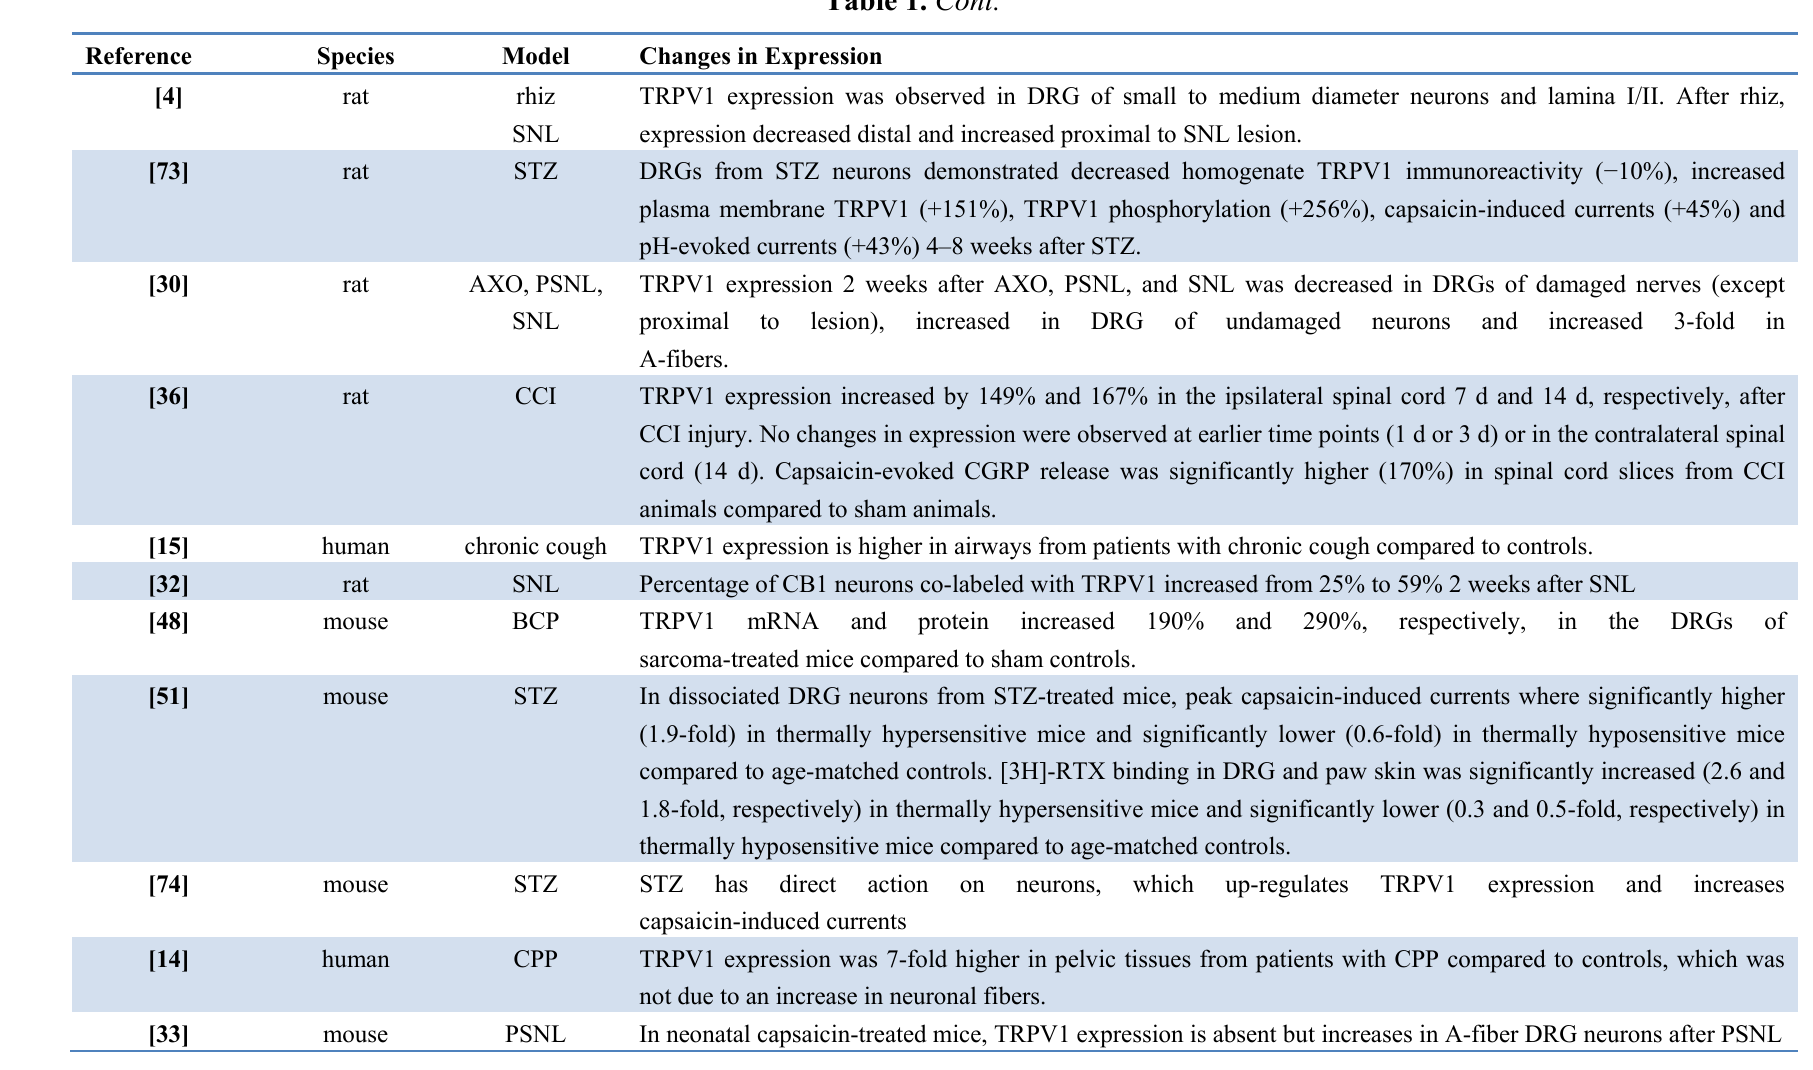
In neonatal capsaicin-treated mice, TRPV1 expression is absent but increases in A-fiber DRG neurons after